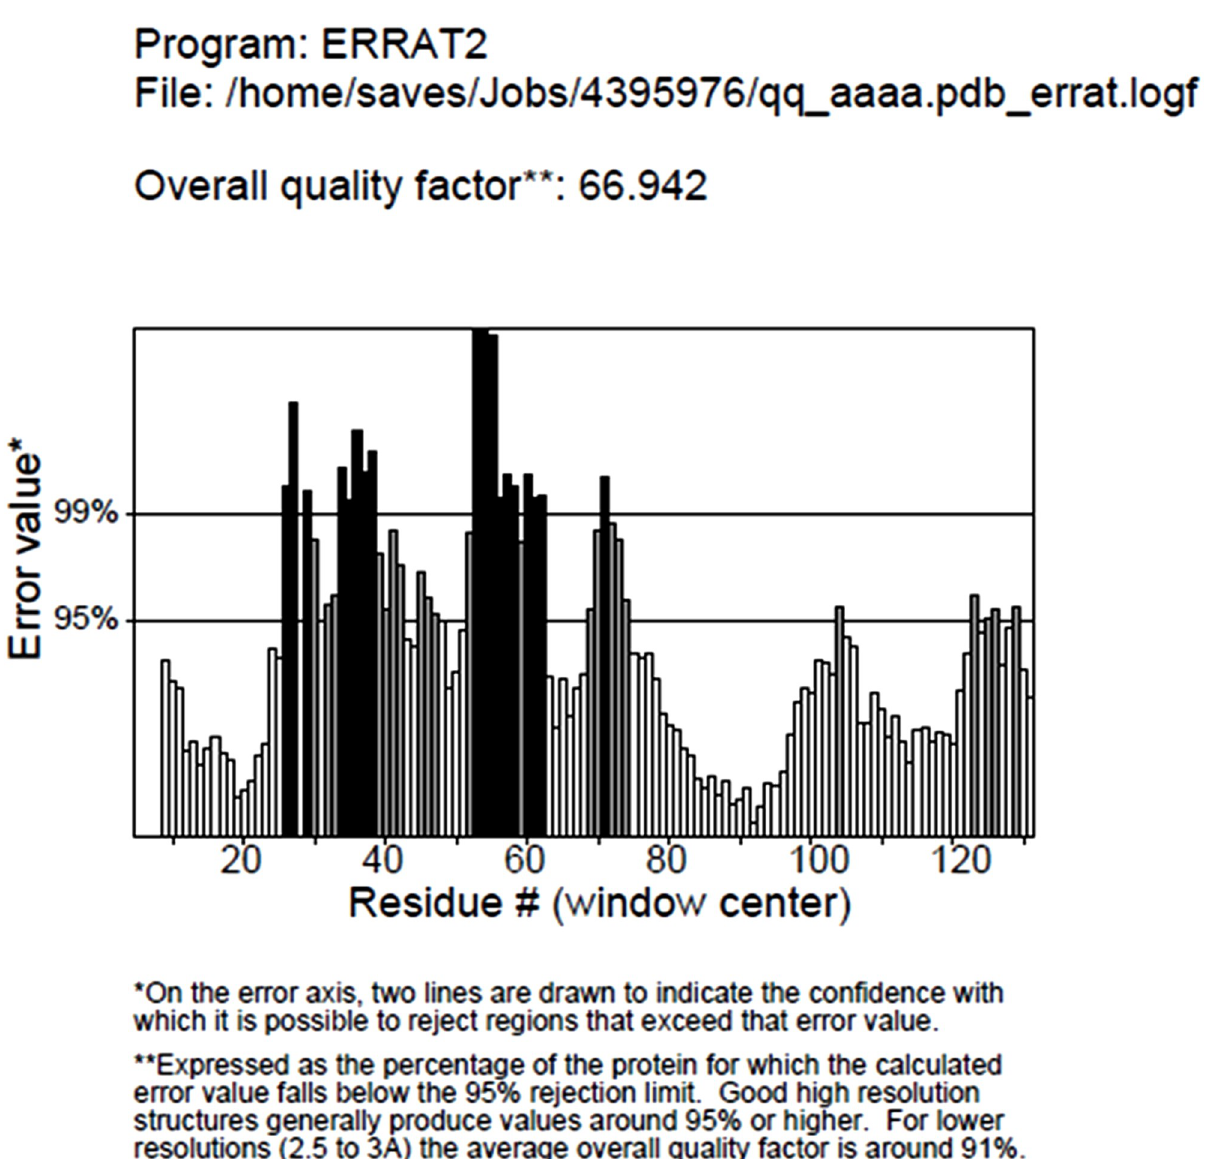
Fig 11. ERRAT measurement of nrtD protein. Values indicate over all structure quality of the traget protein.